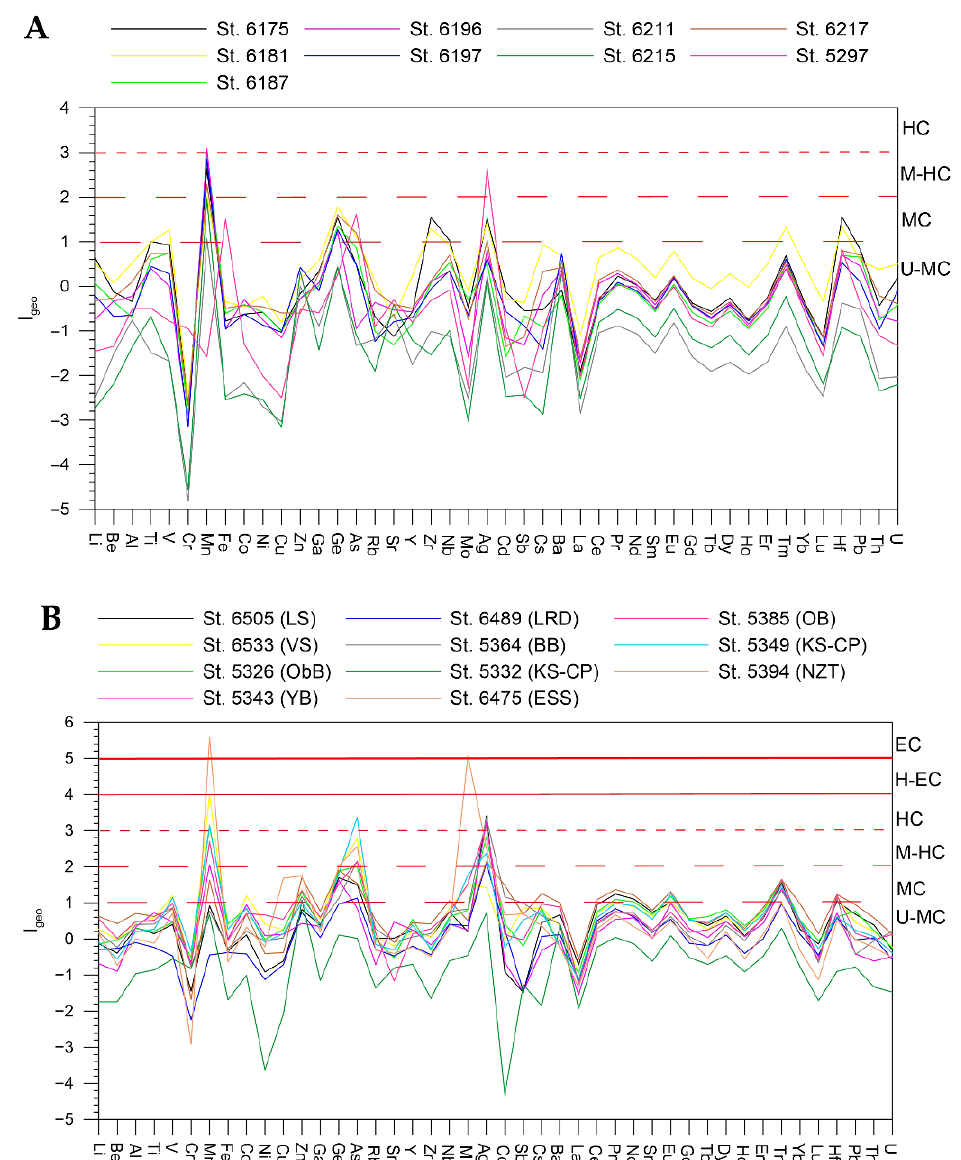
Figure 5. Geoaccumulation index of elements in surface bottom sediments from the Barents ( A ), Kara, Laptev, and East Siberian ( B ) Seas. Expansion of sampling site abbreviations is presented in Figure 4. U-MC—Uncontaminated to moderately contaminated; MC—moderately contaminated; M-HC—Moderately to heavily contaminated; HC—Heavily contaminated; H-EC—Heavily to extremely contaminated; EC—Extremely contaminated.